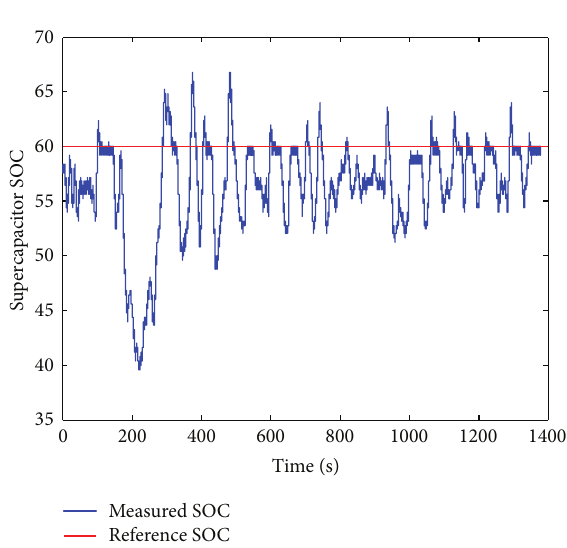
Figure 21: Supercapacitor SOC.